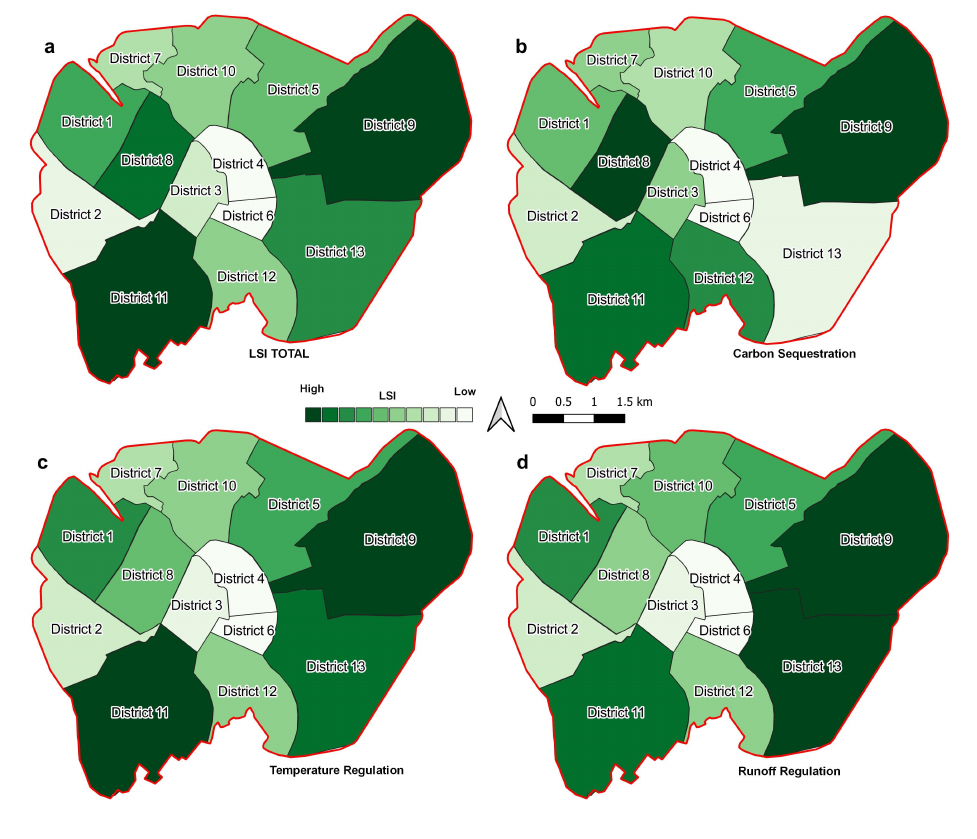
Figure 6. ( a ) Map of the Landscape Services Index (LSI) at the District scale, ( b ) Map of the provision of Carbon sequestration at the District scale, ( c ) Map of the provision of Temperature Regulation at the District scale, and ( d ) Map of Runoff Regulation at the District